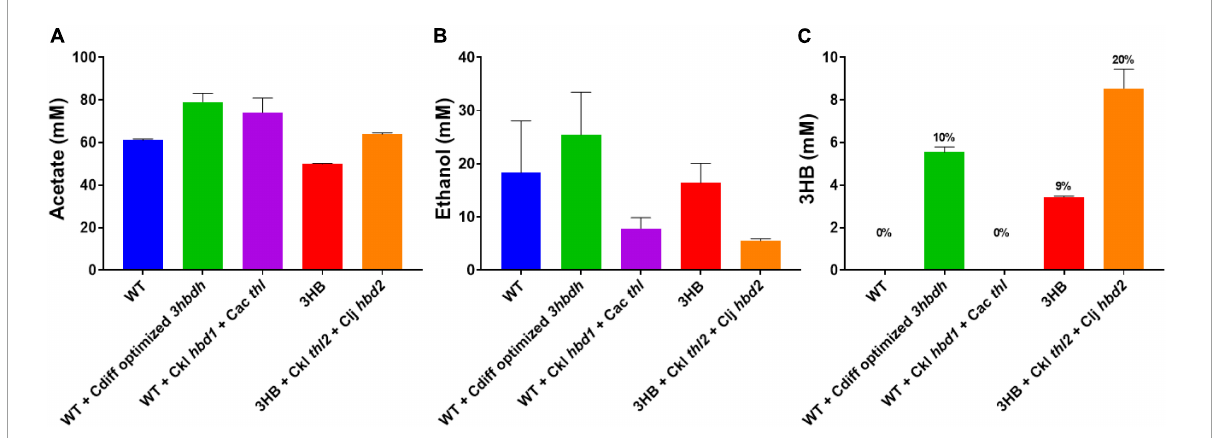
FIGURE6 Autotrophic 3HB production in bottle fermentations. Strains were grown on syngas in 250 mL pressure bottles with 70% CO, 10% H 2 , and 20% CO 2 . (A) Acetate production, (B) ethanol production, and (C) 3HB production. Carbon distribution to 3HB out of the total products is given as a percentage above bars. Error bars show standard error of the mean (SEM) for 3 biological replicates.